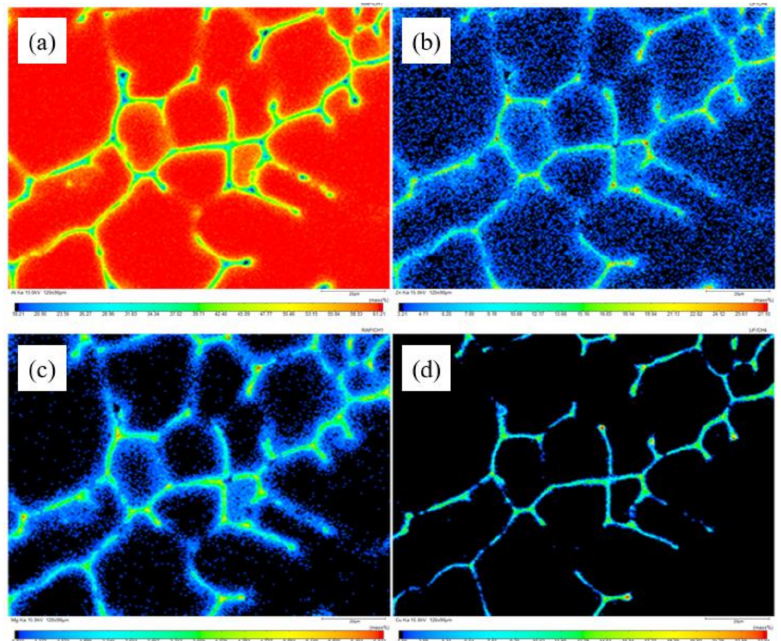
Figure 11. Main elemental distribution in UT-SC sample of alloy C: ( a ) Al; ( b ) Zn; ( c ) Mg; ( d )